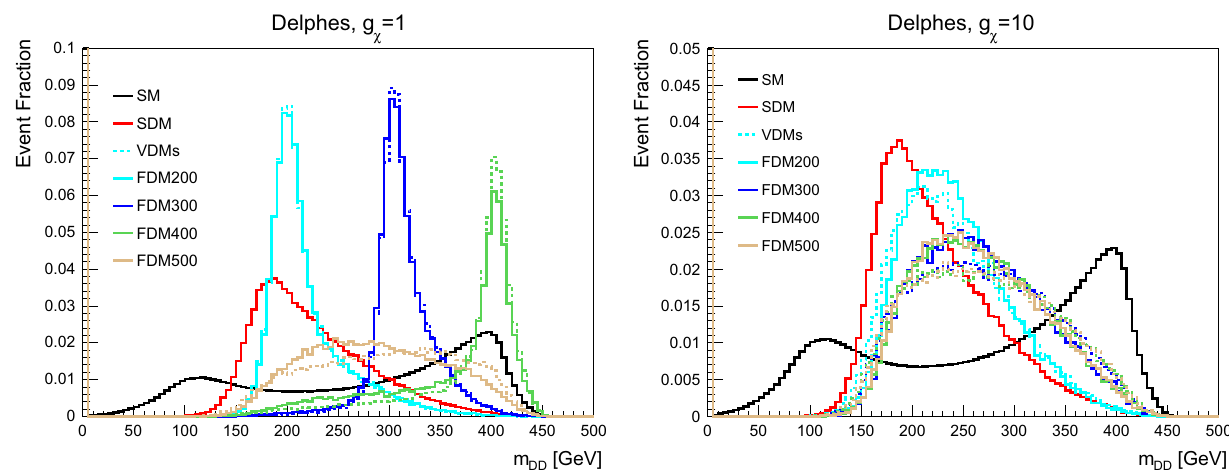
Fig. 9 Invariant mass of DM (neutrino) pair for signal (background) corresponding to two different choices of g χ in FDM model. The left panel: g χ = 1. The right panel: g χ = 10. The meanings of lines are same as in Fig.